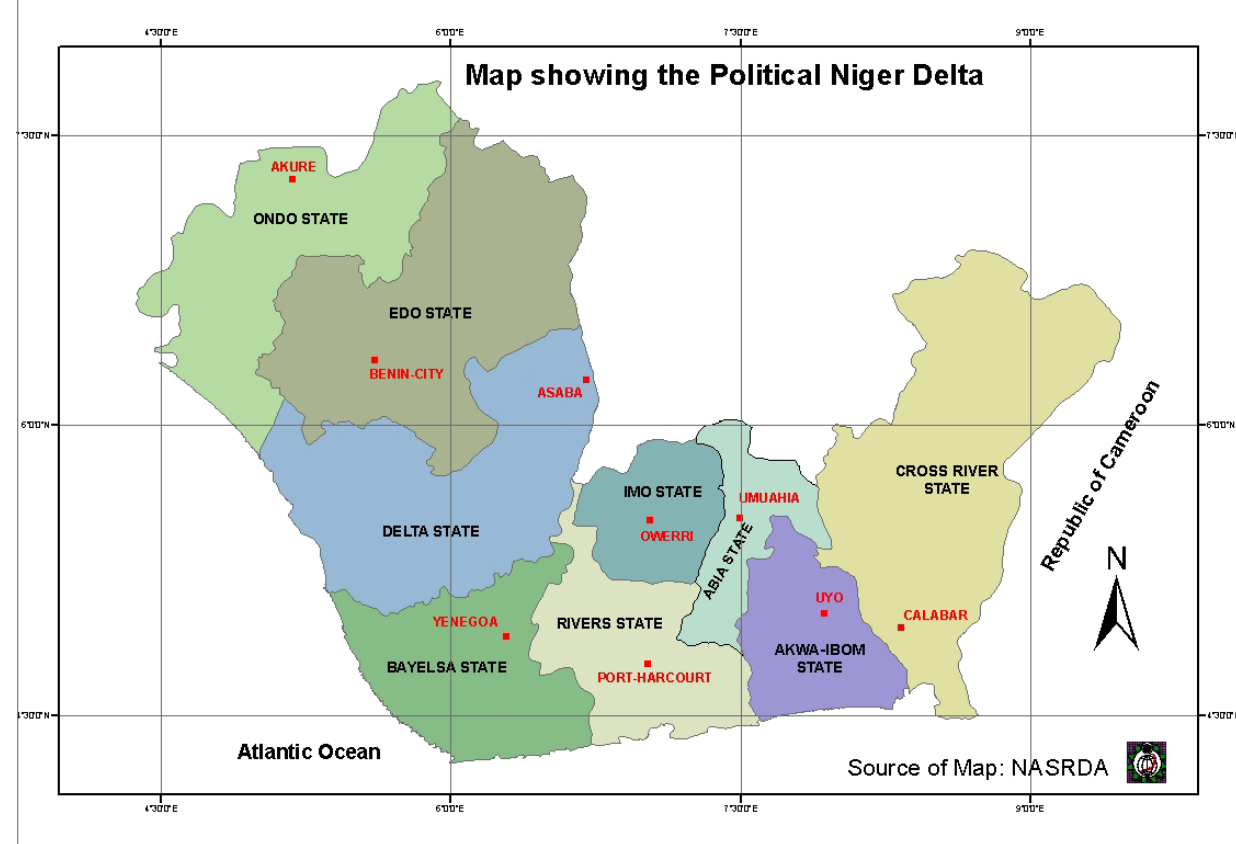
Figure 1. Map of the political Niger Delta. Adapted image from NASRDA